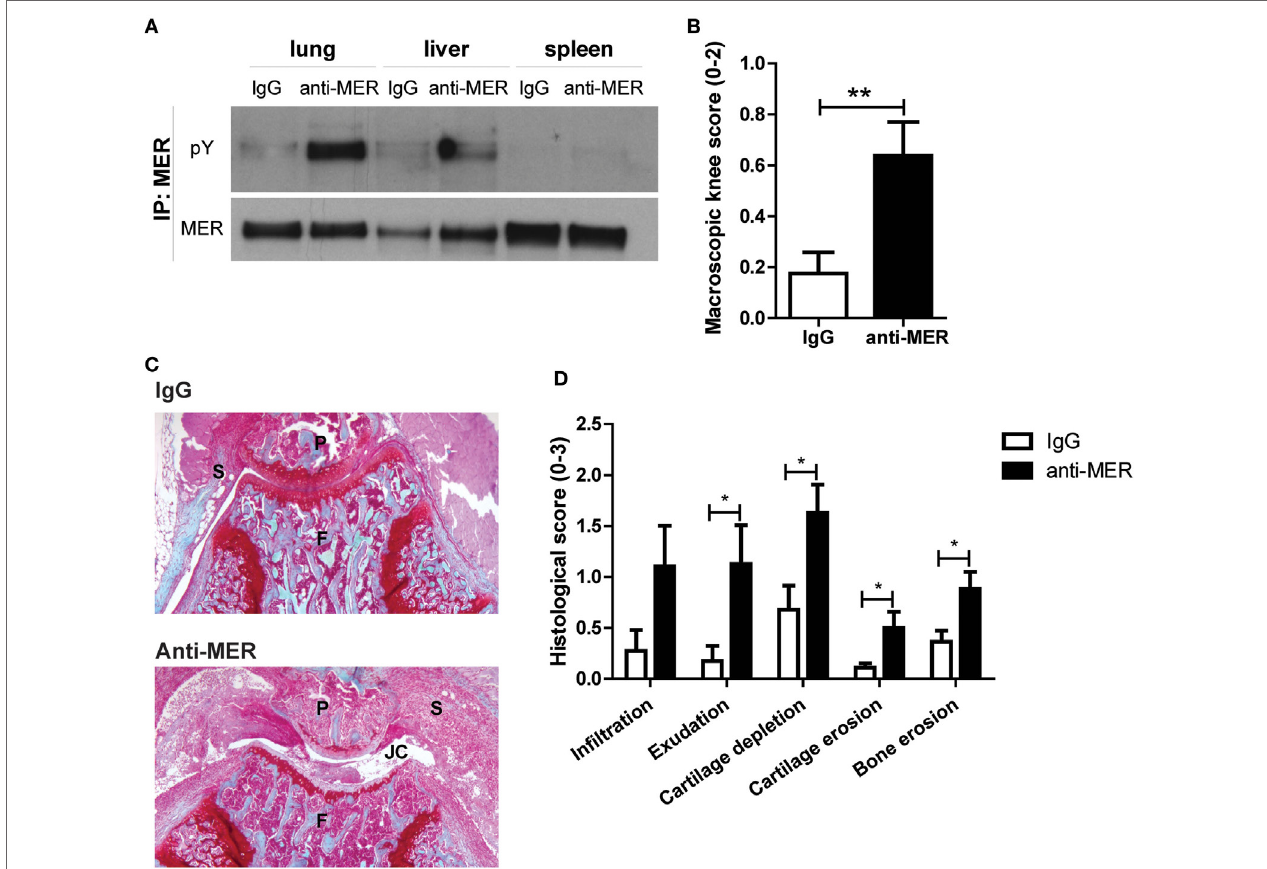
FigUre 4 | Effect of MER-specific antibody treatment on clinical severity and pathology of collagen-induced arthritis (CIA). (a) Mice with CIA were intravenously injected with IgG or anti-MER ( n = 11–12 mice). Two mice were euthanized 1 h after injection. Lung, liver, and spleen were isolated and samples were immunoprecipitated (IP) for MER and immunoblotted for MER or phosphorylation (pY) ( n = 1). (b) Macroscopic score of knee joints as determined by swelling and blood vessel formation ( n = 20–22 knee joints). (c) Shown are representative pictures of histological knee joint sections stained with safranin O and fast green of each group. (D) Histological knee joint sections were scored for the arthritis parameters depicted. Three semi-serial sections per joint were scored in a random and blinded manner with an arbitrary score from 0 to 3 ( n = 20–22 knee joints). P, patella; F, femur; S, synovium; JC, joint cavity. For (b–D) , data are presented as mean + SEM. * p < 0.05, ** p < 0.01 with unpaired t -test. See also Figure S4 in Supplementary